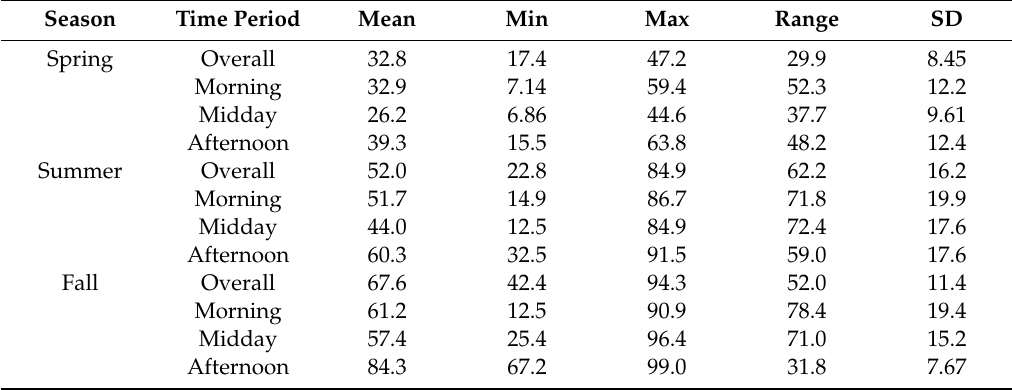
Figure 3. The average percent of shade availability in outdoor enclosures at Lincoln Park Zoo throughout the day for each season. Table 3. Average percent of shade availability across enclosures by season and time of